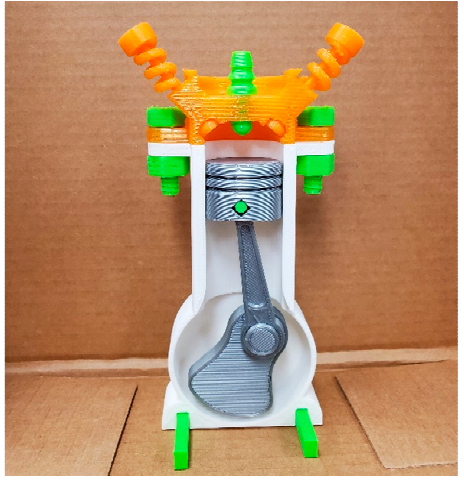
Figure 3. Combustion engine model [69].